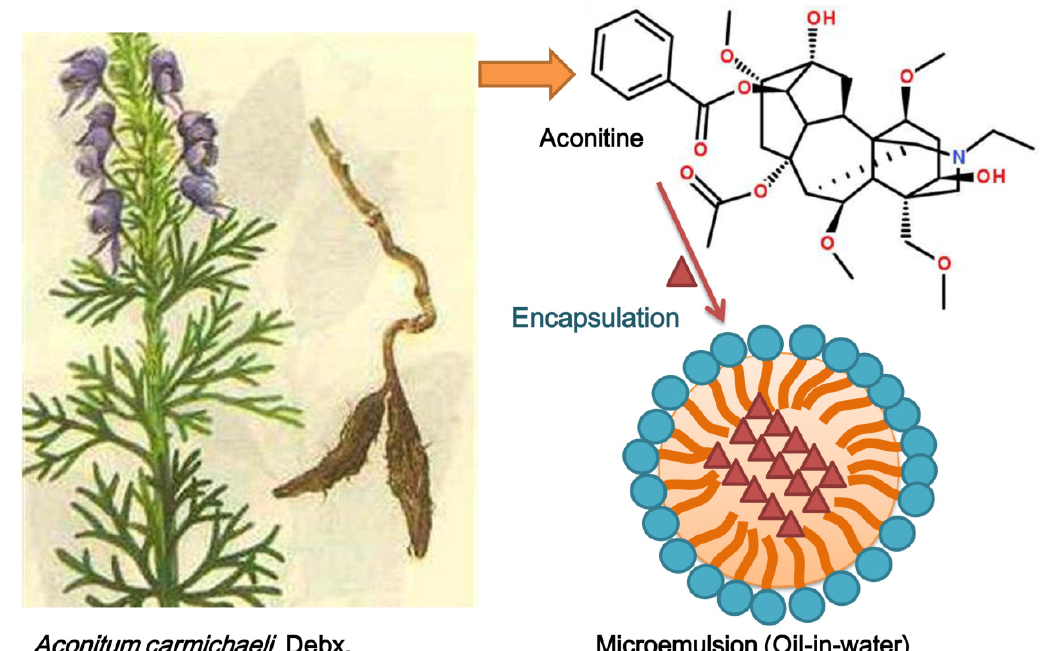
Figure 1. Chemical structure of aconitine and schematic diagram of the drug molecules being encapsulated into the microemulsion.